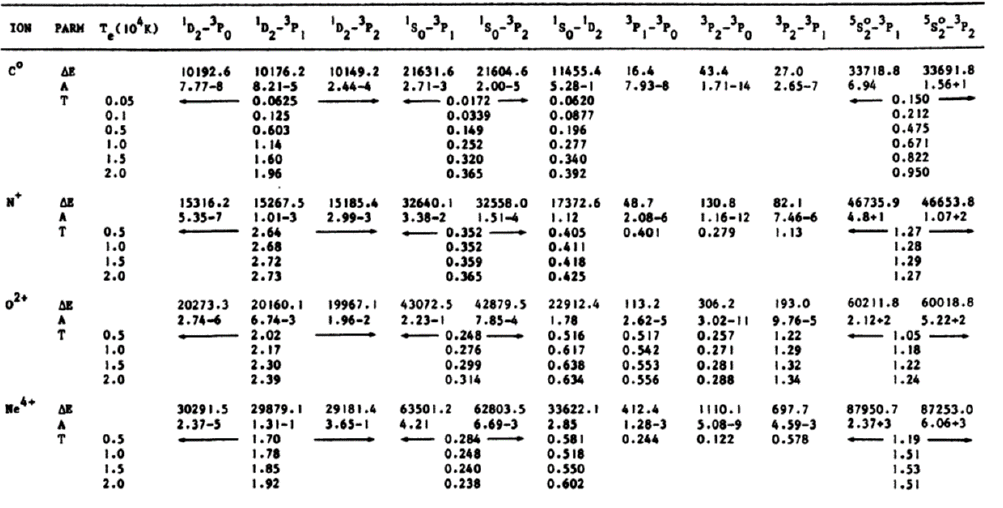
Figure 1. Excerpt from Table 6 of [15] showing the atomic database for the carbon isoelectronic